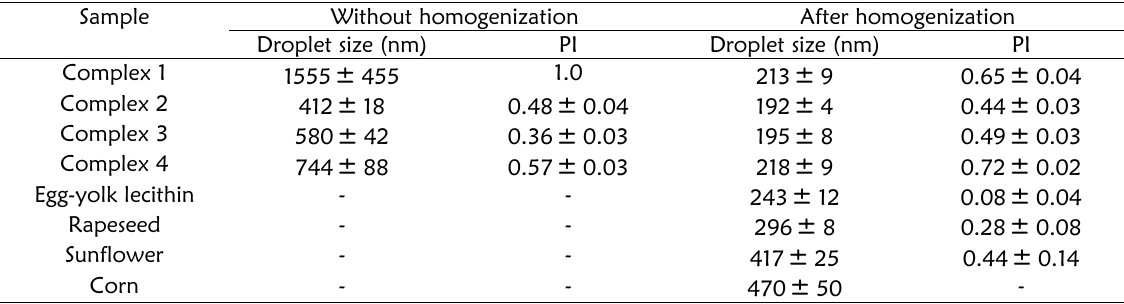
Table 3: Droplet sizes after homogenization of different samples [19, 26, 37]. Sample